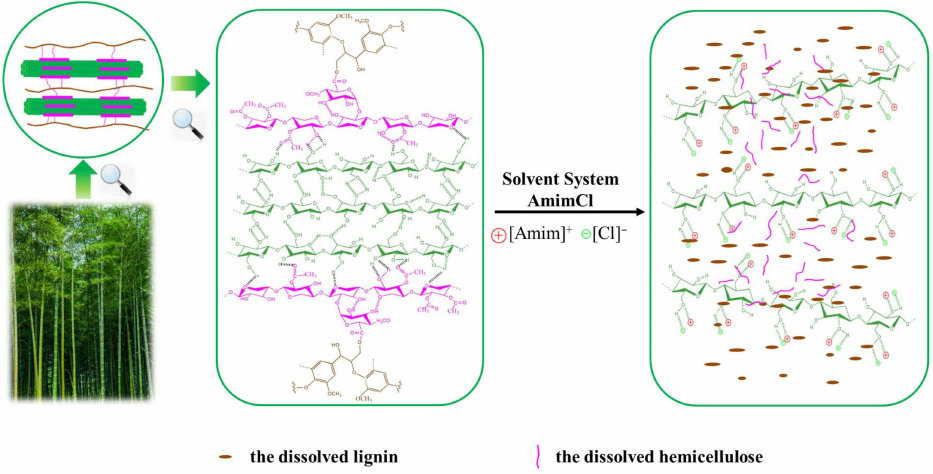
Figure 3. Dissolution mechanism of pretreated waste disposable paper cups in AmimCl solvent